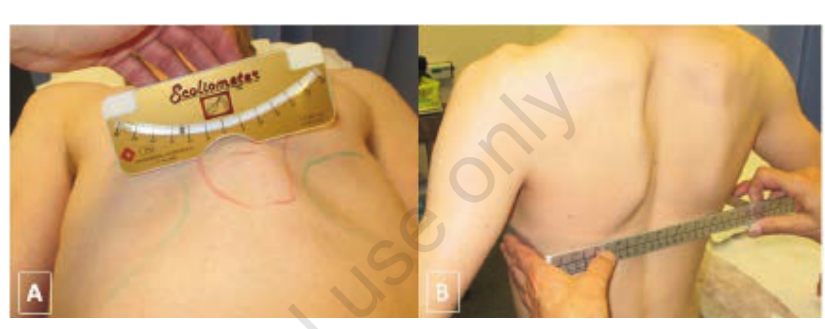
Figure 2. CT images demonstrating a patient with a pectus carinatum deformity (A) and a pectus excavatum deformity (B).